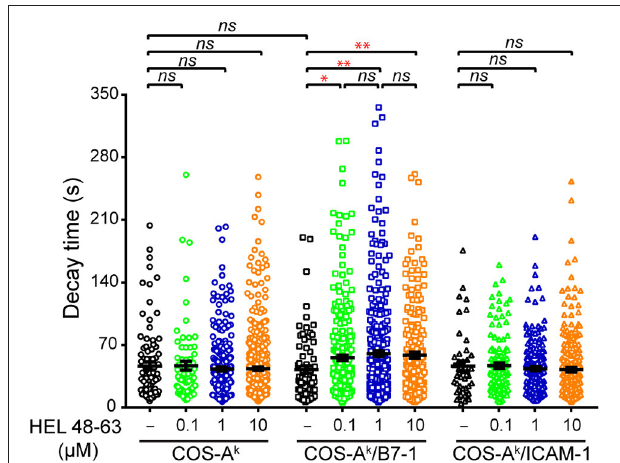
FIGURE 5 | Comparisons of decay time ( τ ) of calcium response in naive CD4 + T cells upon different stimulation. Naive 3A9 TCRtg CD4 + T cells stained with Fluo-4 PBX were loaded onto COS APC monolayers at 37 ◦ C and observed for 45min. APC cells were loaded or not with 0.1, 1, and 10 µ M HEL 48–63. Analysis of average decay time ( τ ) was performed as described in Materials and Methods. Data: mean ± SEM. Mann–Whitney tests were performed using Graphpad prism 7.0 for comparisons between two groups. Statistical significance was set at 0.05, and p -values < 0.05 were denoted in red. * p < 0.05 and ** p <